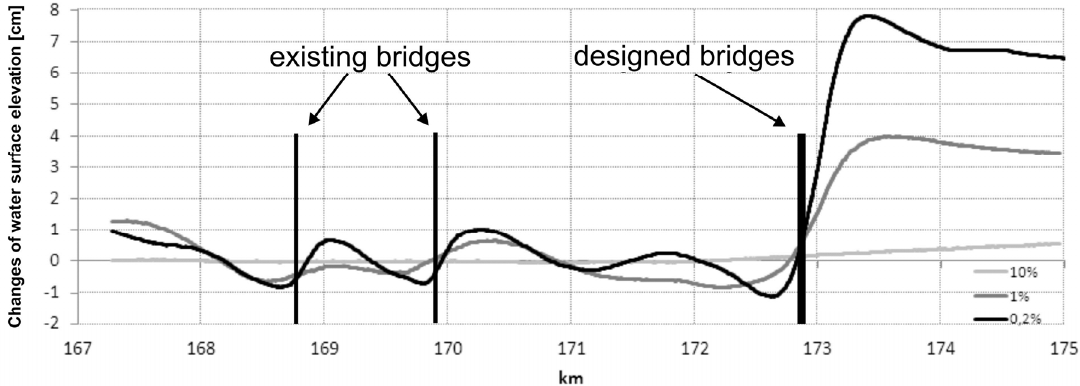
Figure 9. The longitudinal profile of water elevations changes for maximum flows Q 10% , Q 1% , and Q 0.2%